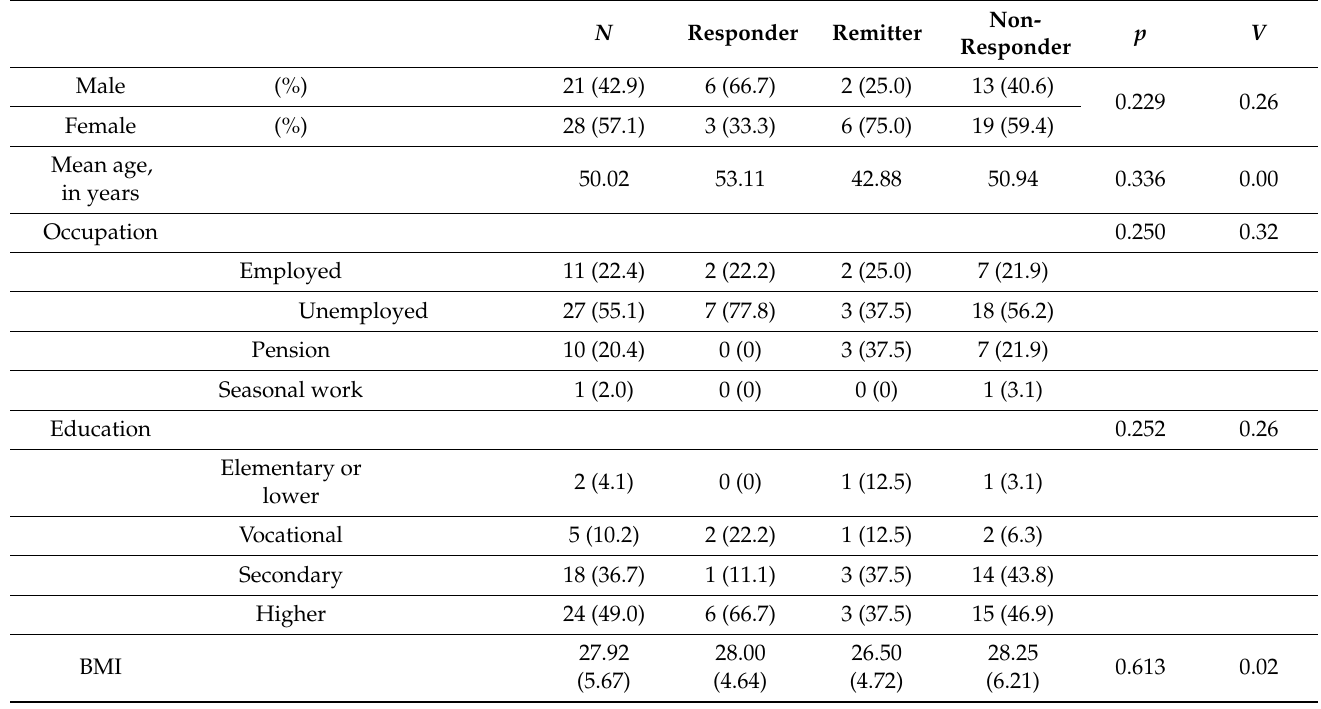
Table 1. Demographics and clinical